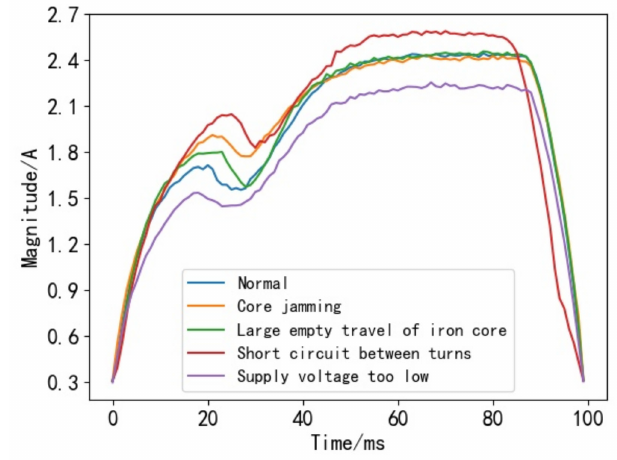
Figure 14. Current waveform with